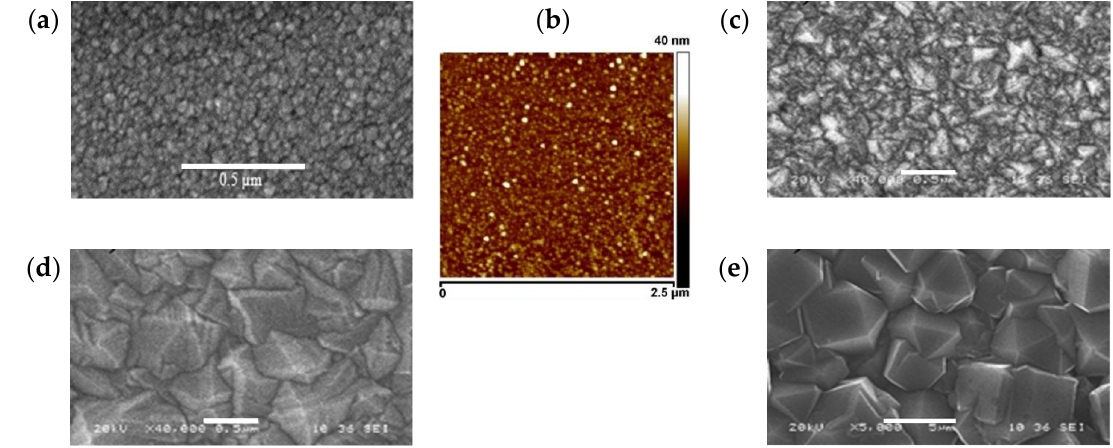
Figure 1. ( a ) SEM image of sample S1 (scale bar = 0.5 µm). ( b ) A 2.5 µm × 2.5 µm AFM image of S1. The average grain size is around 3–5 nm in diameter. ( c ) SEM image of sample S2 (scale bar = 0.5 µm). ( d ) SEM image of sample S3 (scale bar = 0.5 µm). ( e ) SEM image of sample S4 (scale bar = 5 µm).